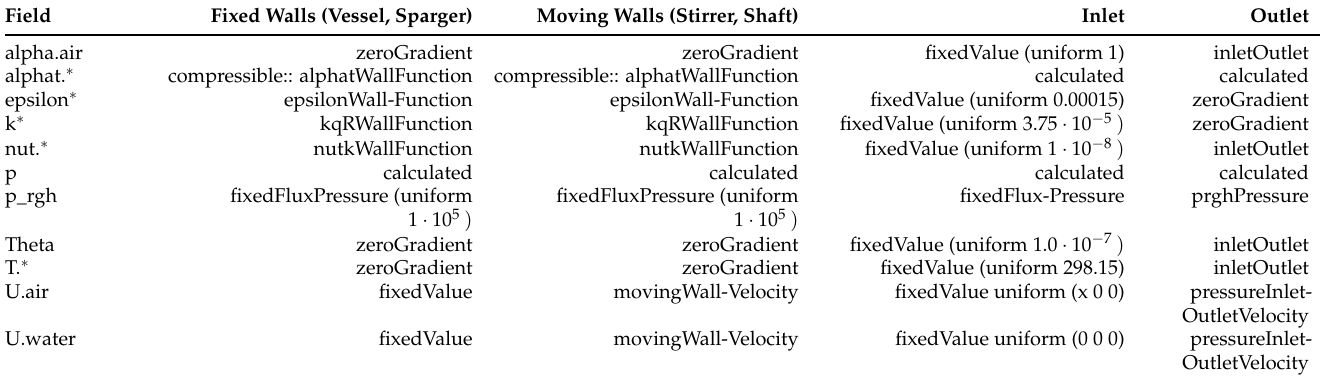
Table A1. Boundary